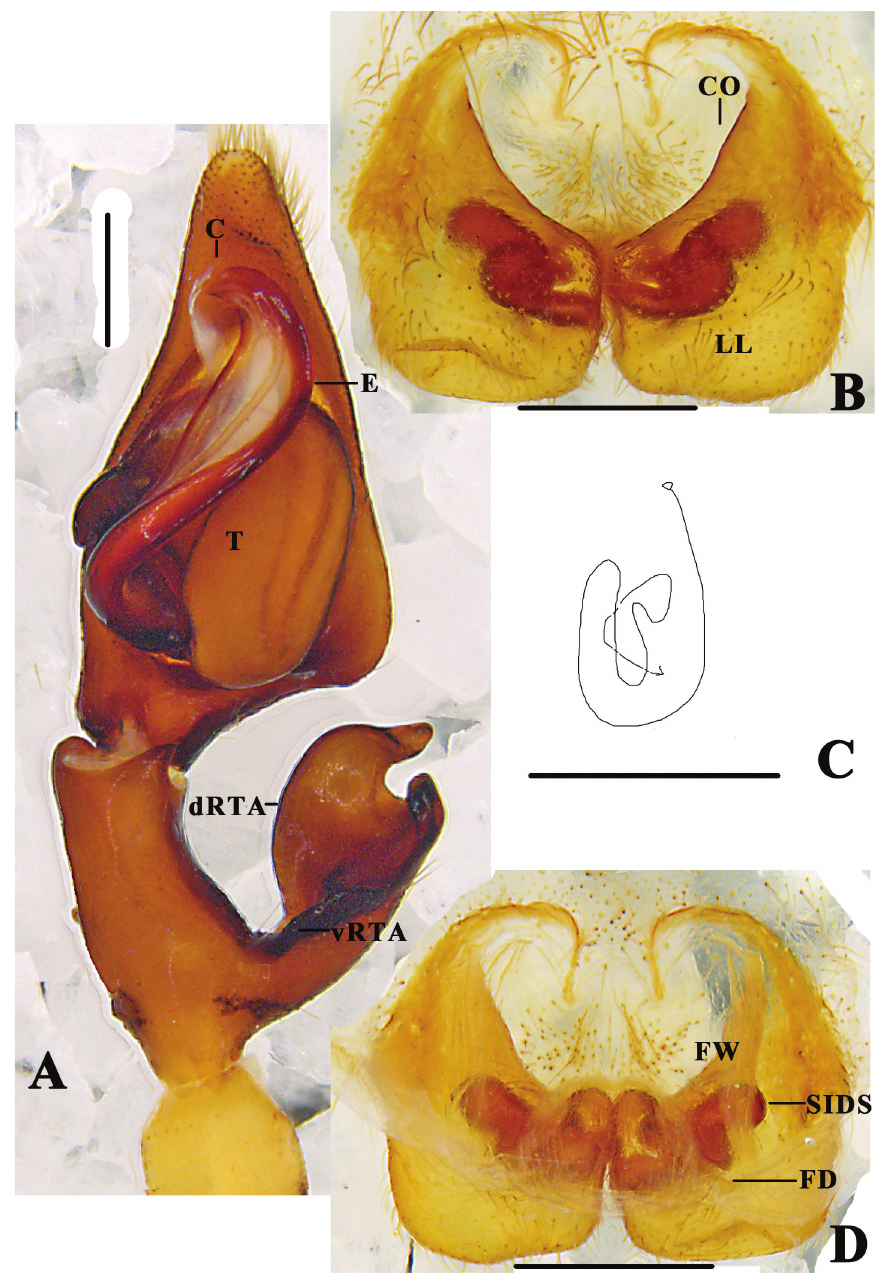
Figure 12. Pseudopoda signata Jäger, 2001 A left male palp, ventral B epigyne, ventral C schematic course of internal duct system in right part, dorsal D vulva, dorsal. Abbreviations: C–conductor; E–em- bolus; dRTA–dorsal retrolateral tibial apophysis; T–tegulum; vRTA–ventral retrolateral tibial apophysis; CO–copulatory opening; LL–lateral lobes; FD–fertilisation duct; FW–first winding; SIDS–sclerotised internal duct system. Scale bars: 0.5